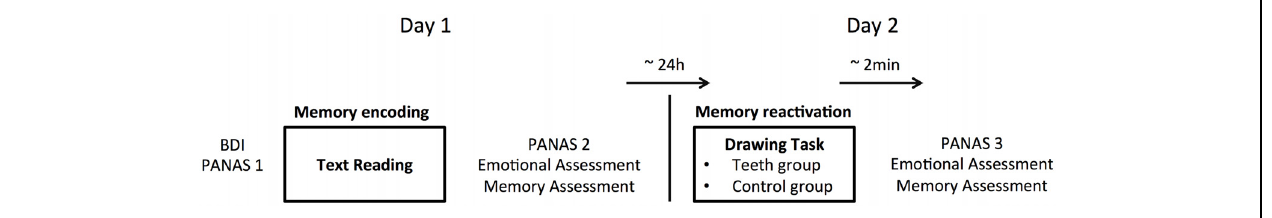
FIGURE 1 | Illustration of the experimental procedure. On day 1, participants filled in Beck’s Depression Inventory (BDI) and Positive and Negative Affect Schedule (PANAS) 1 questionnaires. Then, participants read the text, performed an emotional evaluation and a memory evaluation of the text, and